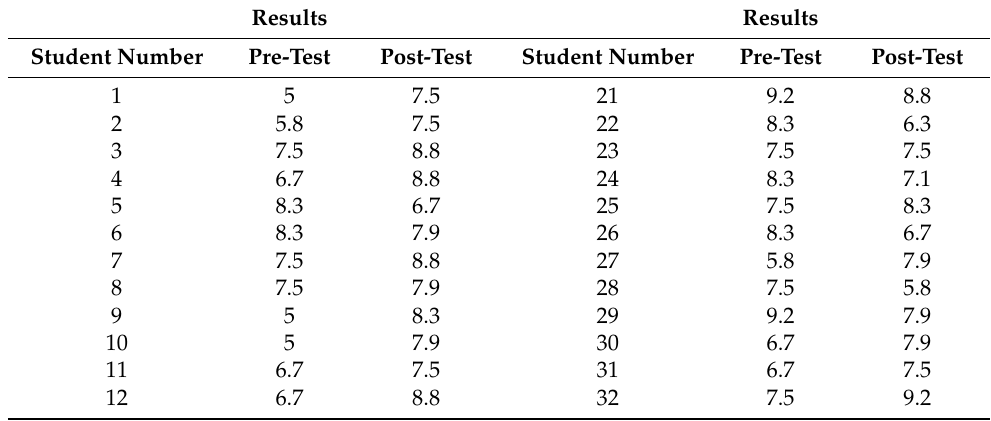
Table A5. E-word test